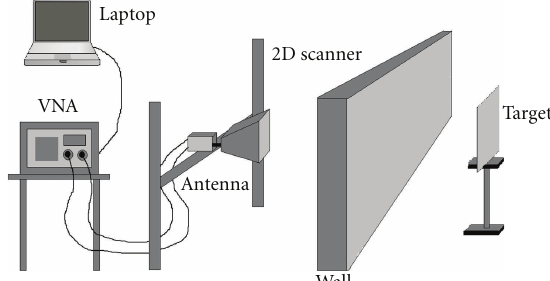
Figure 5: TWI setup.